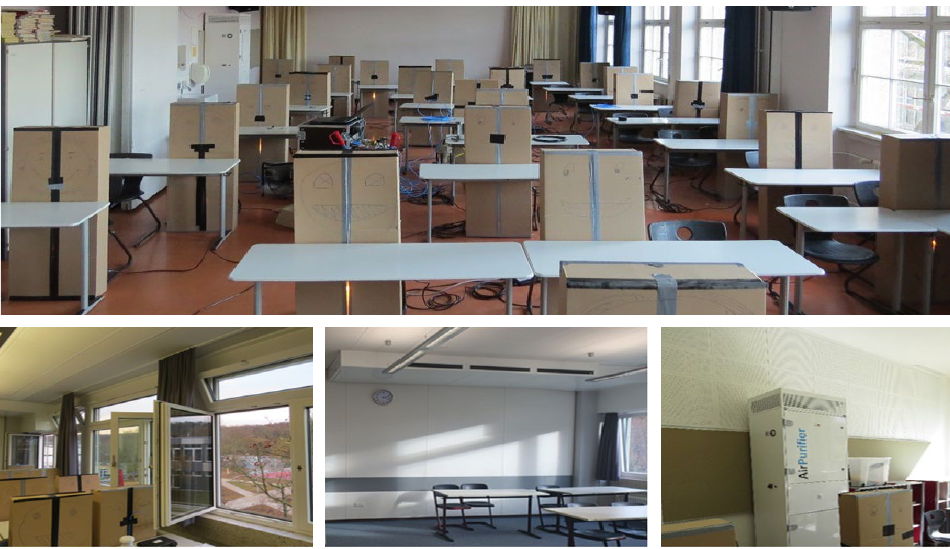
Figure 6. Experimental set up ( top ), exemplary window ventilation ( bottom left ), exemplary decen- tralised ventilation system ( bottom middle ), exemplary air purifier ( bottom right ).